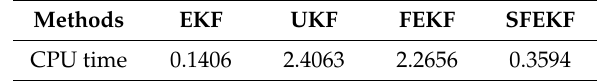
Table 2. The CPU time cost of 50 Monte Carlo simulations for the four comparison methods.